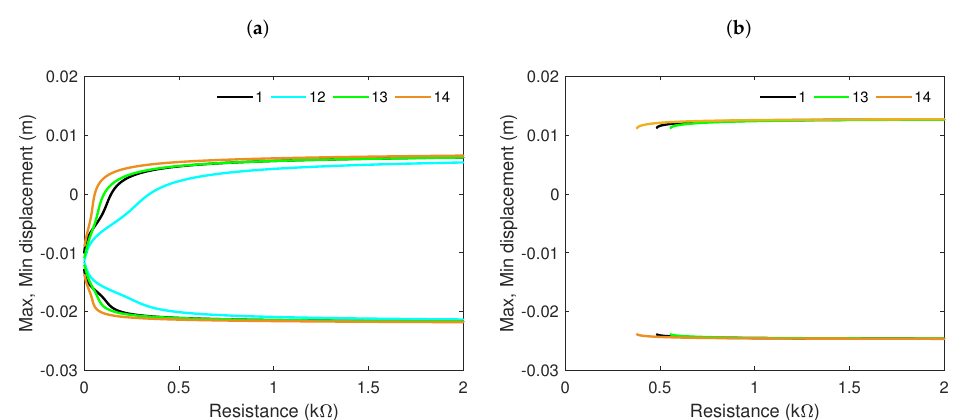
Figure 11. Maximal and minimal displacement of the magnet as a function of resistance, for the solution from the bottom ( a ) and top ( b ) branch and a frequency of 38 rad/s. Figure 12 presents the foldover (multistability) region (blue area) in a two-dimensional space ( ω , R ). The red solid curve marks the border of multistability. Panel (a) shows the results for the active coil segment 1, panel (b) corresponds to segment 12, panel (c) for segment 14, and finally panel (d) gives the results for segment 14. In the foldover region, two stable (2S) and one unstable (1U) solutions occur. These solutions depend on the initial conditions of the magnet.